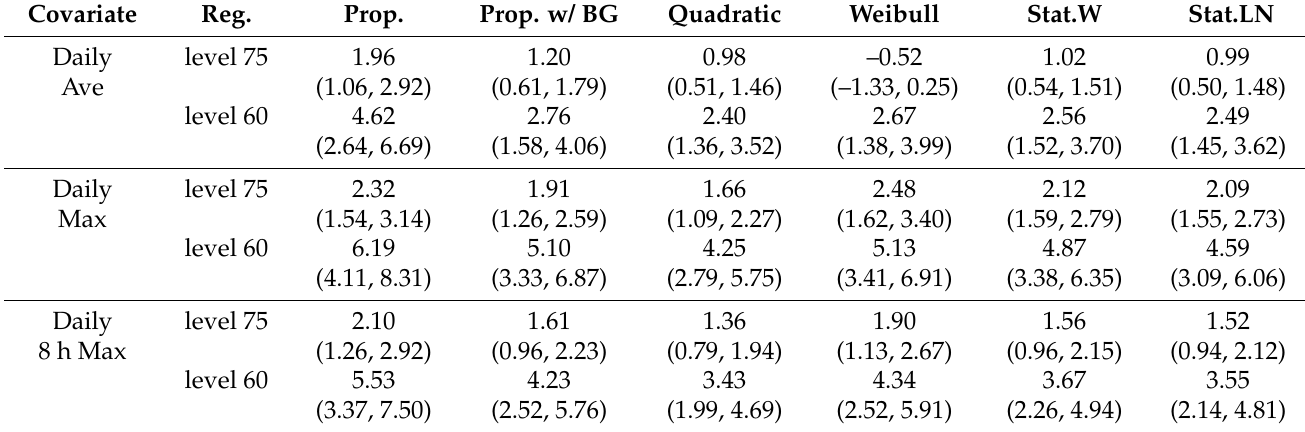
Table 3. Posterior means and 95% confidence intervals of total mortality reduction per 1000 deaths (1998–2000): city-specific rollback and CDL